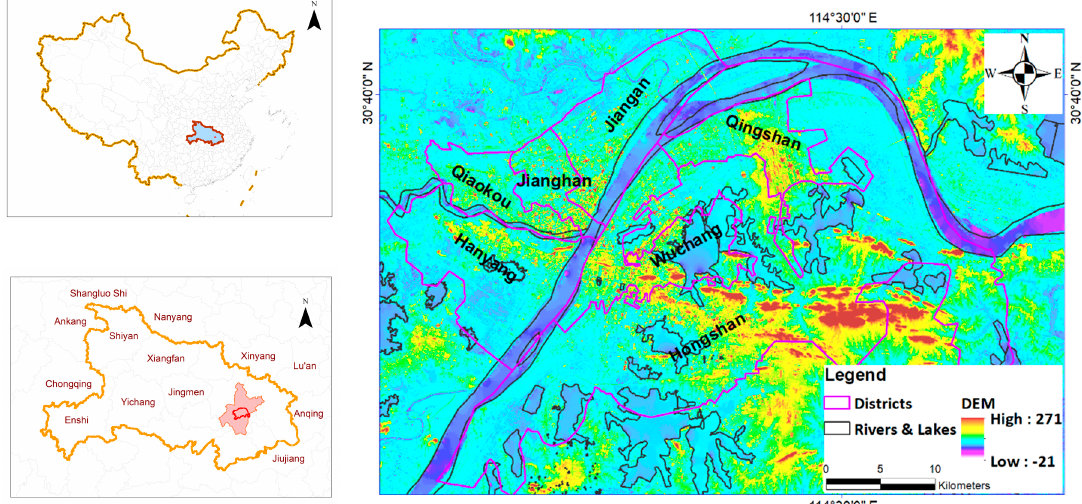
Figure 1. The study area is the downtown districts of Wuhan, Hubei, China, including Jiang’an, Jianghan, Qiaokou, Hanyang, Wuchang, Hongshan, and Qingshan Districts.